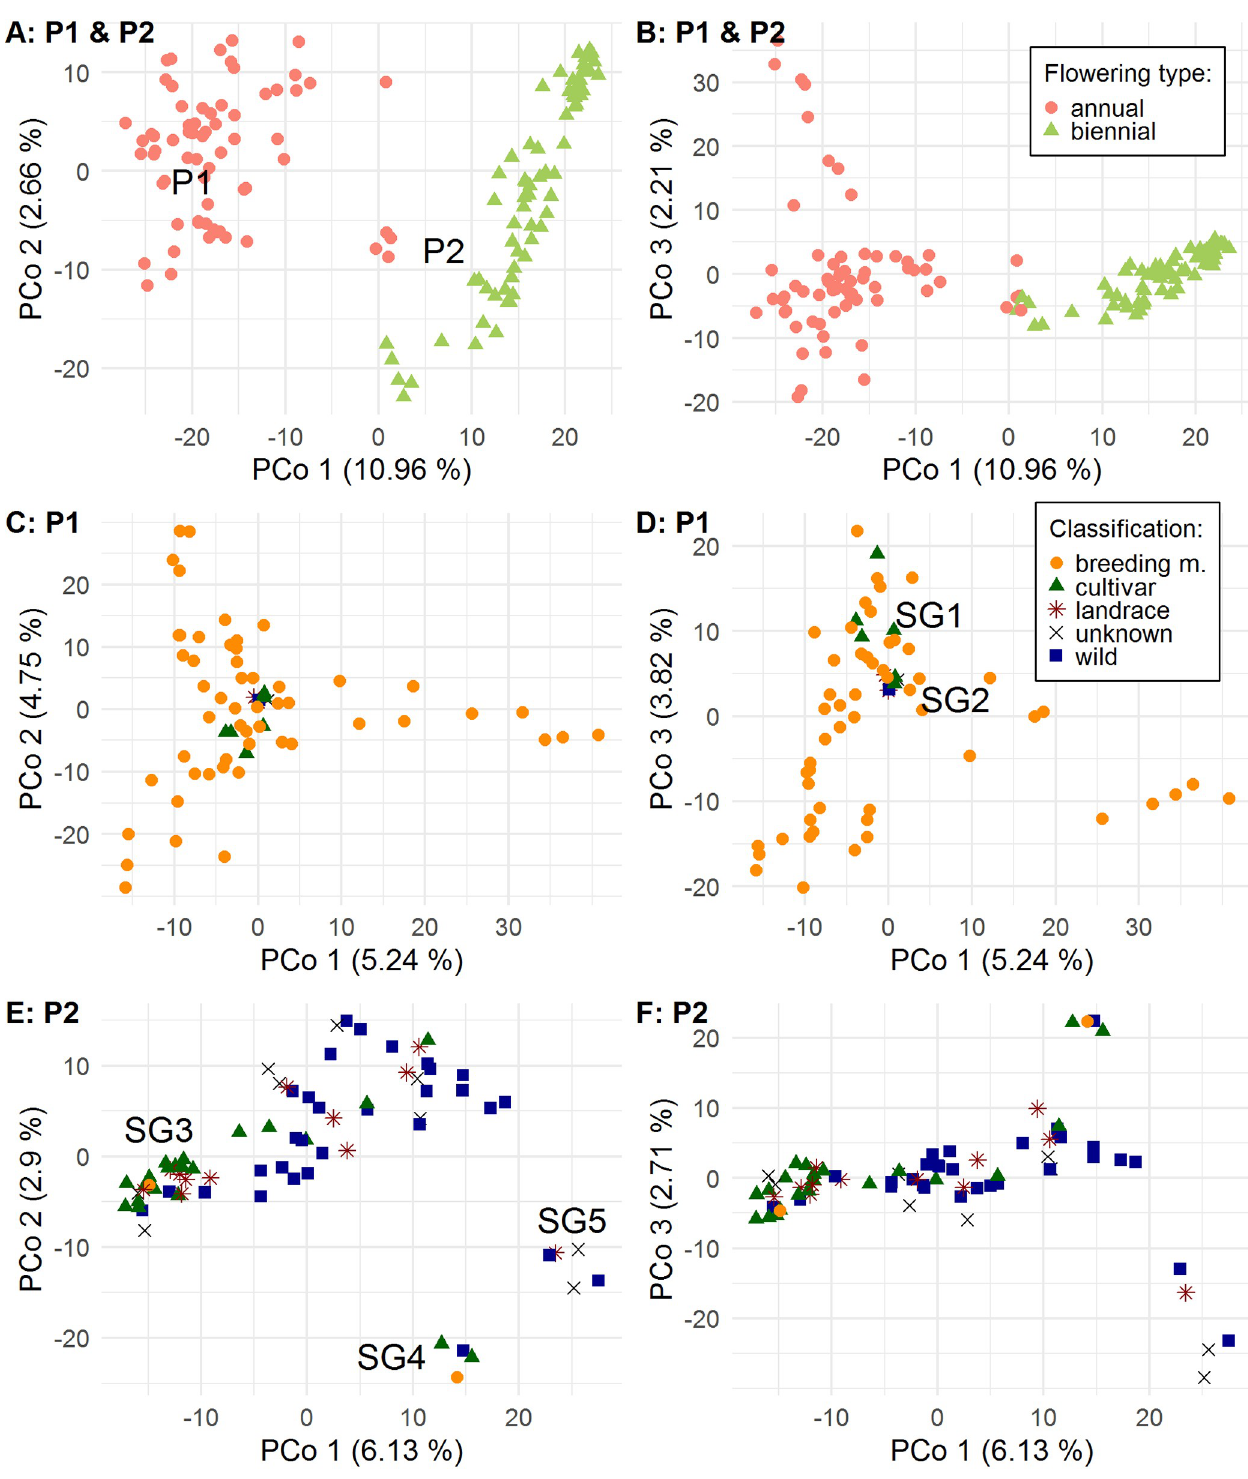
Fig 2. Principal coordinate analysis (PCoA) for 137 caraway accessions based on 13,155 SNP loci using Darwin software. (A) and (B) display PCoA for both subpopulations and discriminate flowering types. (C) and (D) display PCoA for subpopulation P1, containing all annual flowering types except SG4 and discriminate classifications. (E) and (F) display PCoA for subpopulation P2, containing all biennial flowering types and SG4 and discriminate classifications.